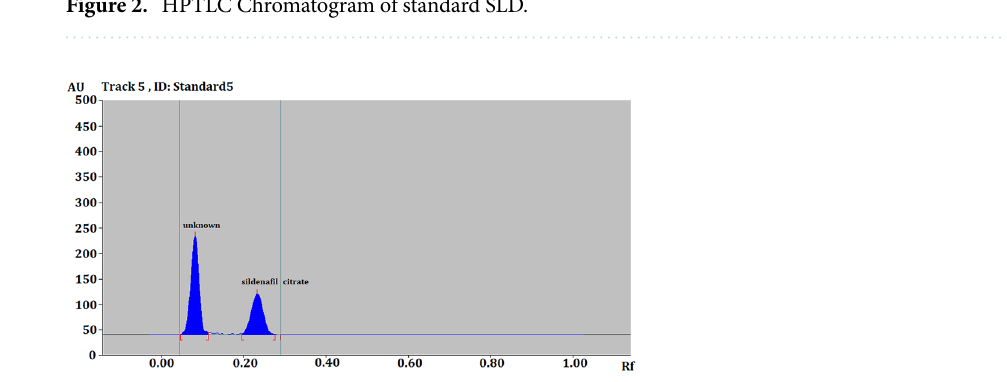
Figure 2. HPTLC Chromatogram of standard SLD.